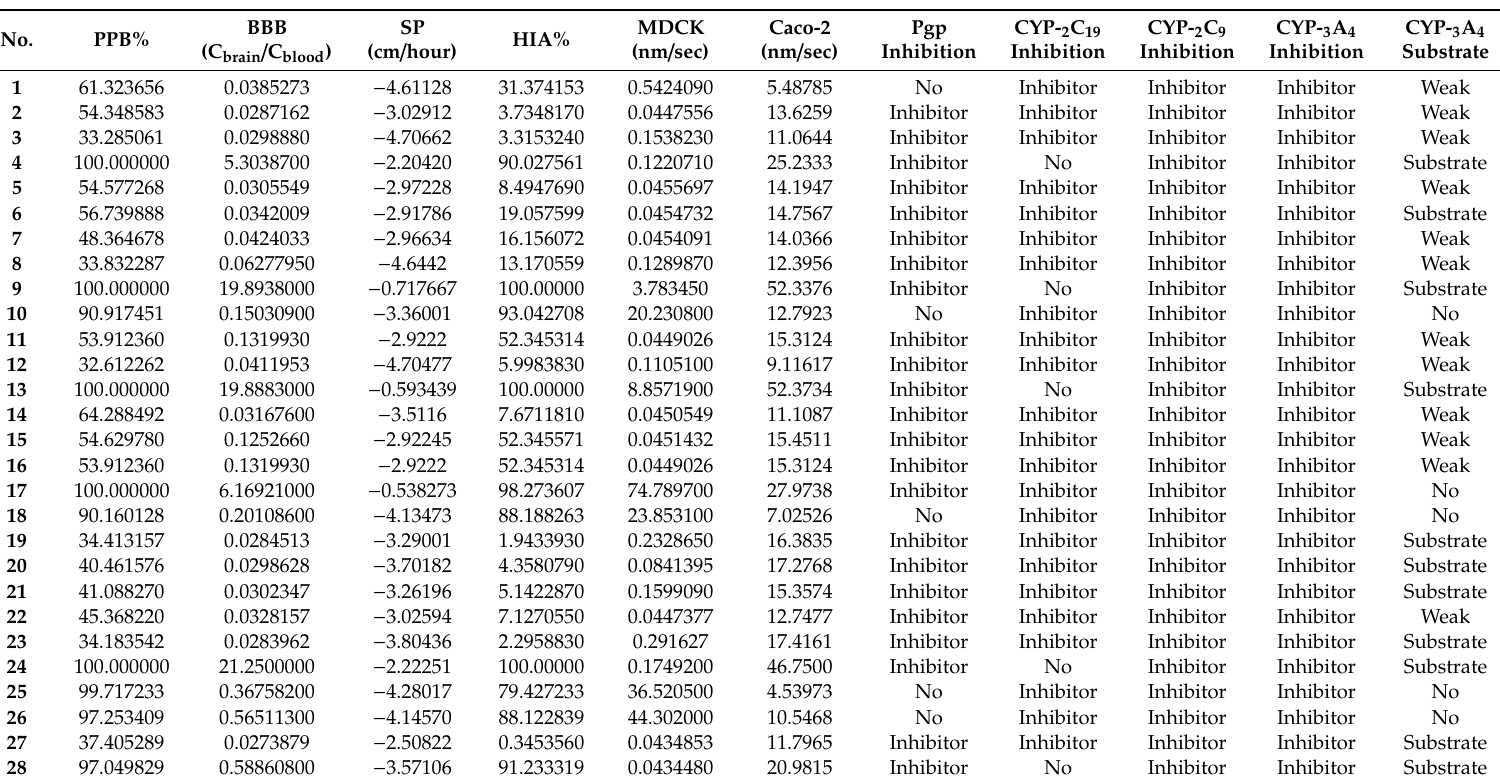
Table 2. The predicted absorbance, distribution, metabolism, excretion (ADME) properties of the LC–HRESIMS dereplication metabolites of the crude Premna odorata leave extract using the in silico predicts absorption, distribution, metabolism, excretion, and toxicity (PreADMET) method.